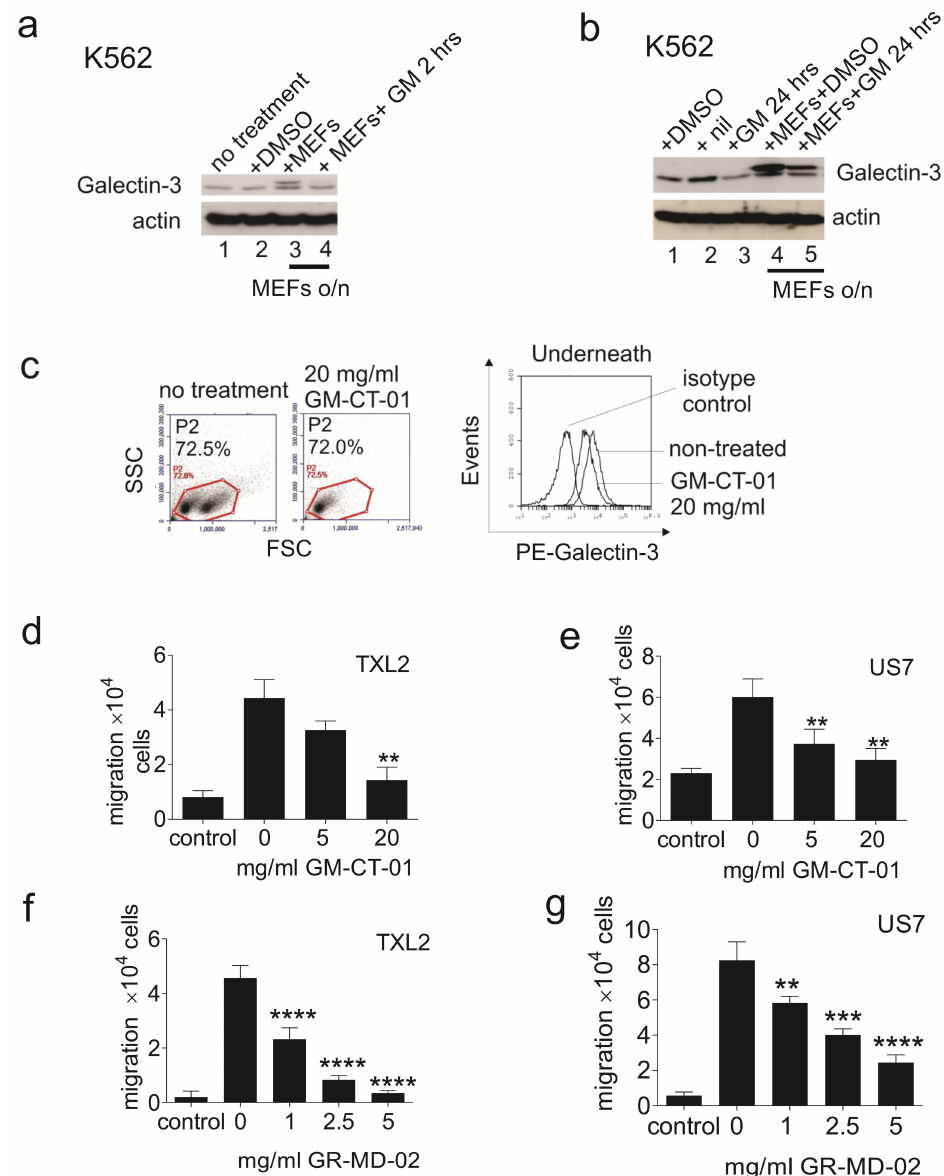
Figure 2. Interference of interaction of extracellular Galectin with leukemia cells by large inhibitory carbohydrates. ( a , b ) Western blot analysis of Galectin expression in K562 cells grown in suspension or co-cultured overnight with MEFs. Actin—loading control. ( a ) Treatment with 5 mg/mL GM- CT-01 (GM) for 2 h. ( b ) Treatment of cells with 1 µ M nilotinib (nil) or 2 mg/mL GM-CT-01 for 24 h. ( c ) BCP-ALL cells in co-culture with OP9 cells were treated with 20 mg/mL GM-CT-01 for 2 h. BCP-ALL cells from underneath the stroma were assayed for cell surface expression of Galectin-3 using FACS: left, gating; right Galectin-3 cell-surface-positive cells in gate P2. Control, BCP-ALL cells underneath OP9 not treated with GM-CT-01. ( d – g ) Overnight migration of human BCP-ALL TXL2 (Ph-positive) or US7 (Ph-negative) to OP9 stromal cells plated in the bottom of Transwells in the absence or presence of the indicated concentrations of GM-CT-01 ( d , e ) or GR-MD-02 ( f , g ) ** p < 0.01, *** p < 0.001, **** p < 0.0001, one-way ANOVA, between 0 mg/mL compound and samples incubated with the indicated amounts of compound. Controls: only medium, no OP9 cells in the bottom